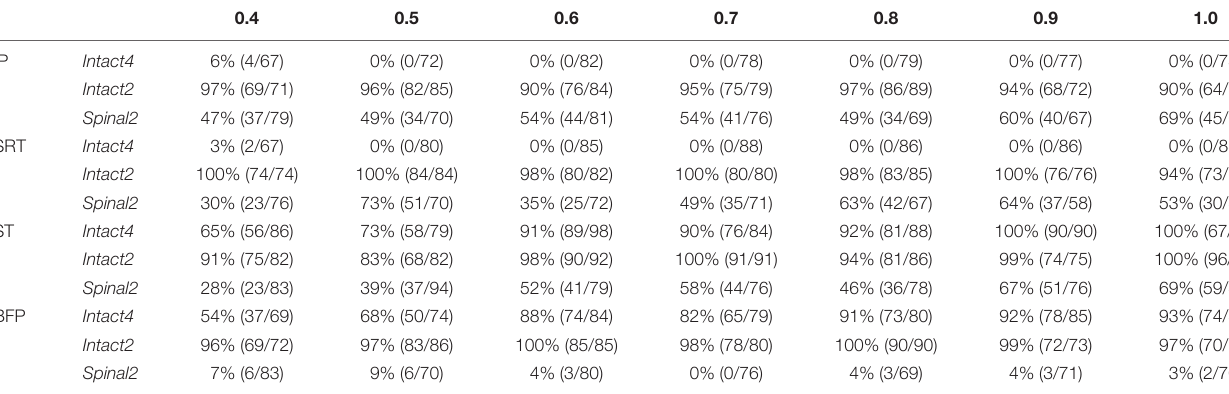
TABLE 4 | Effect of locomotor conditions and state on appearance of double bursts in flexor